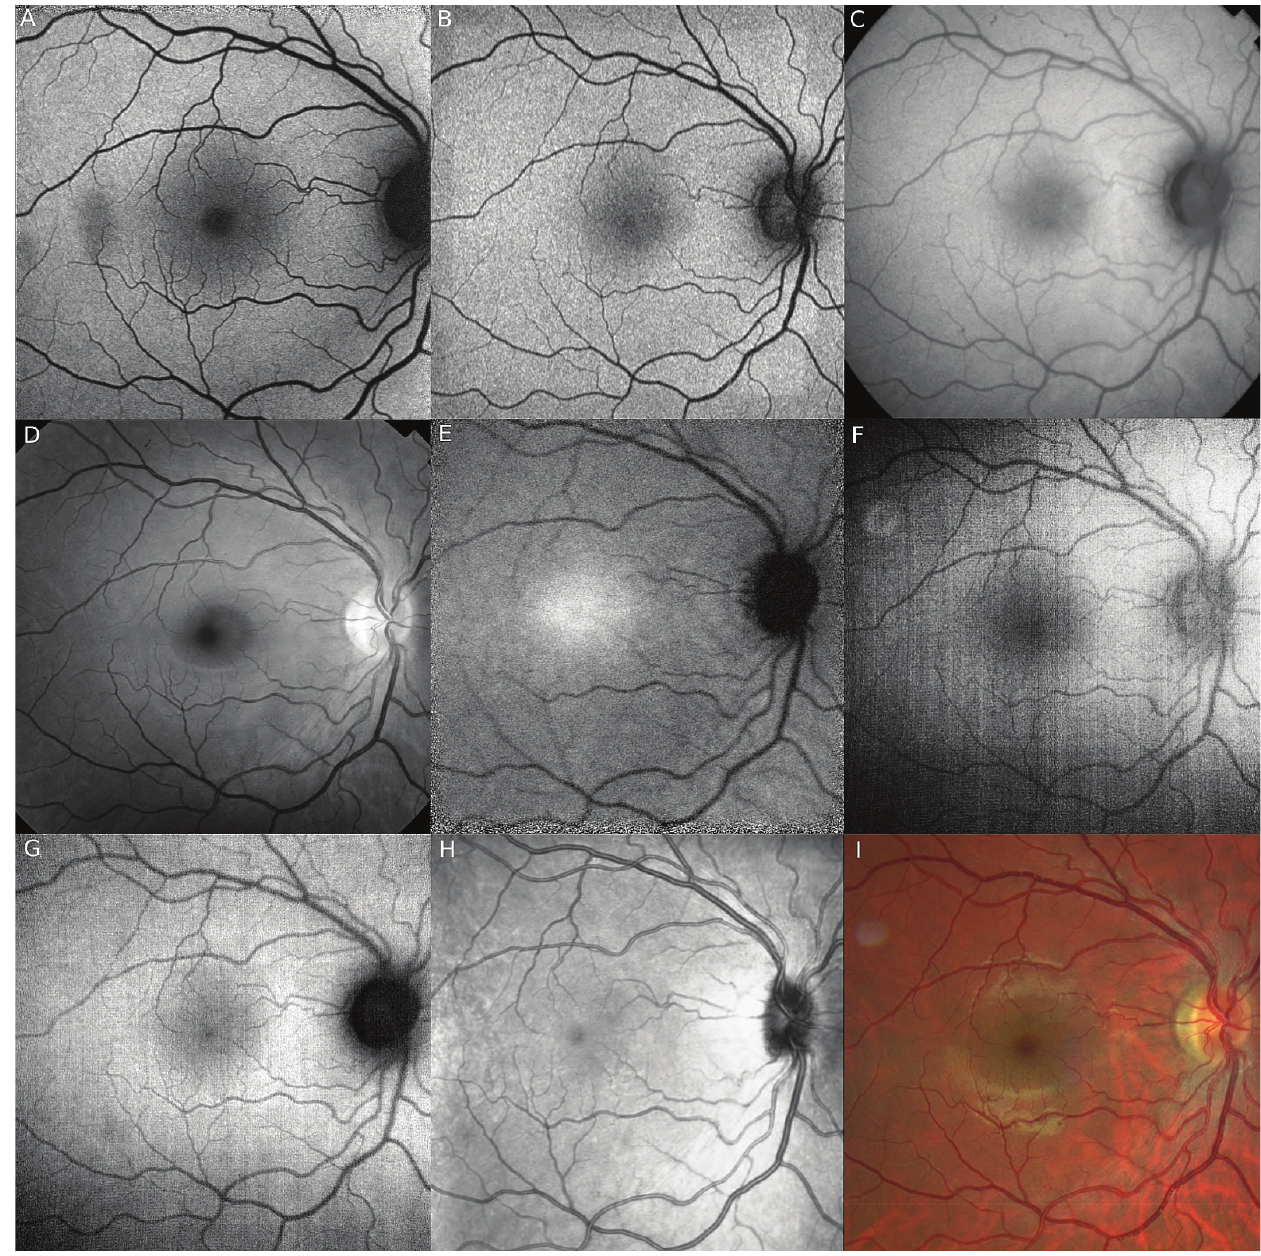
Figure 2. Different autofluorescence techniques imaging a normal right fundus. (A) Blue short-wave autofluorescence (SW-AF), Spectralis (488 nm excitation), scanning laser ophthalmoscope (SLO). The temporal macular hypo-autofluorescence is artifact from a vitreous floater. (B) Green SW-AF, Optos (532 nm excitation), SLO. Note the foveal center is less hypo-autofluorescent (hypo-AF) than in (A). (C) SW-AF, Topcon (535–580 nm excitation), Fundus camera. (D) Red-free image, Topcon. (E) Near-infrared autofluorescence (NIR-AF), Spectralis (787 nm excitation), SLO. Note the fovea is hyper-autofluorescent (hyper-AF) compared with other AF modalities. (F) Blue SW-AF, Clarus 700, Zeiss (435-500 nm excitation). (G) Green SW-AF, Clarus 700, Zeiss (500–585 nm excitation). (H) Near-infrared reflectance image (NIR-R), Spectralis (787 nm) SLO. Note: Neither (D) nor (H) are true AF